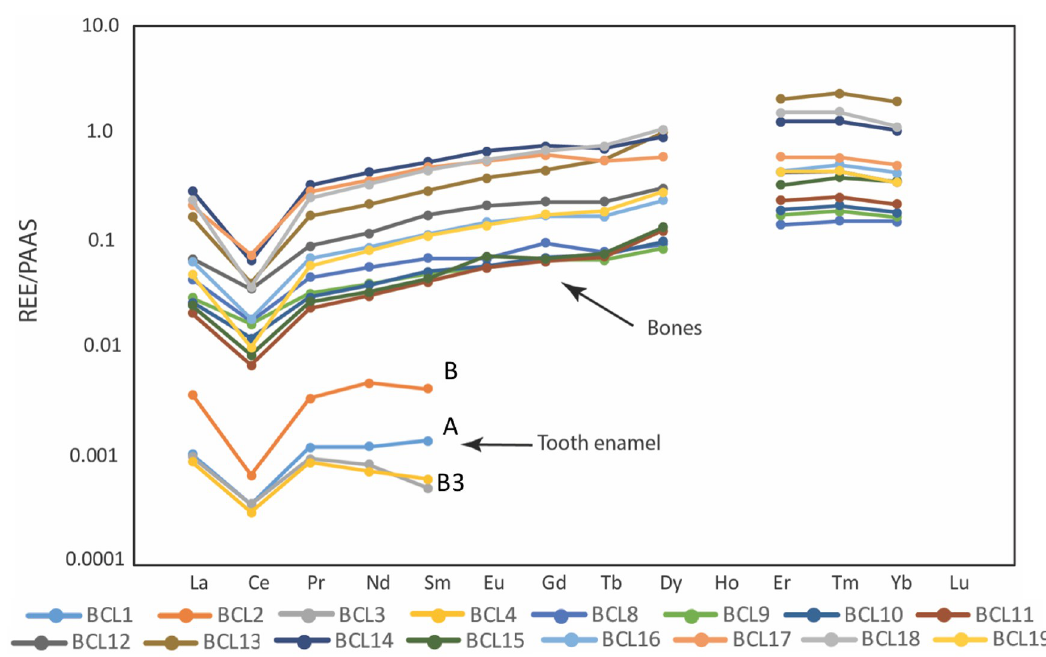
Fig 18. Normalized REE data for tooth enamel (BCL1-BCL4) and bone (BCL8-BCL19). Abbreviations in Table 3. Note the highly elevated REE in bone compared to enamel, indicating postmortem diagenetic change in all of the bone samples.